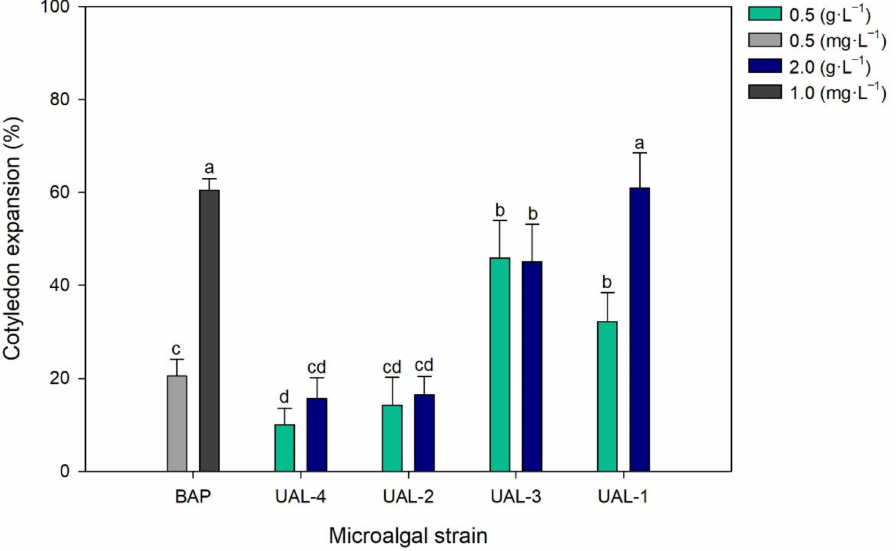
Figure 5. Effect of the microalgal extracts on the weight of cucumber cotyledons. Values represent the percentage of variation with respect to the control (distilled water). Values represent the mean values ± SD. Different letters indicate significant differences ( p <